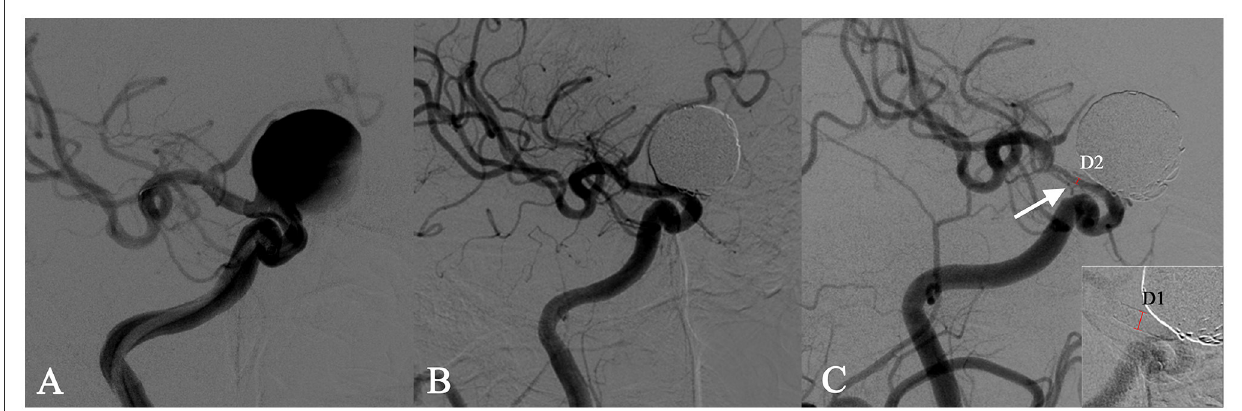
FIGURE1 In-stent stenosis in a man in his 40s who presented with a symptomatic right carotid ophthalmic aneurysm (A) and was treated with the implant of a single PED stent plus coiling. Angiographic images obtained immediately after the intervention showed an unimpeded flow in the stent (B) . The follow-up angiography after 6 months showed a 70% in-stent stenosis (ISS% = 1 – [D2/D1] × 100%) at the distal end of the stent (C)